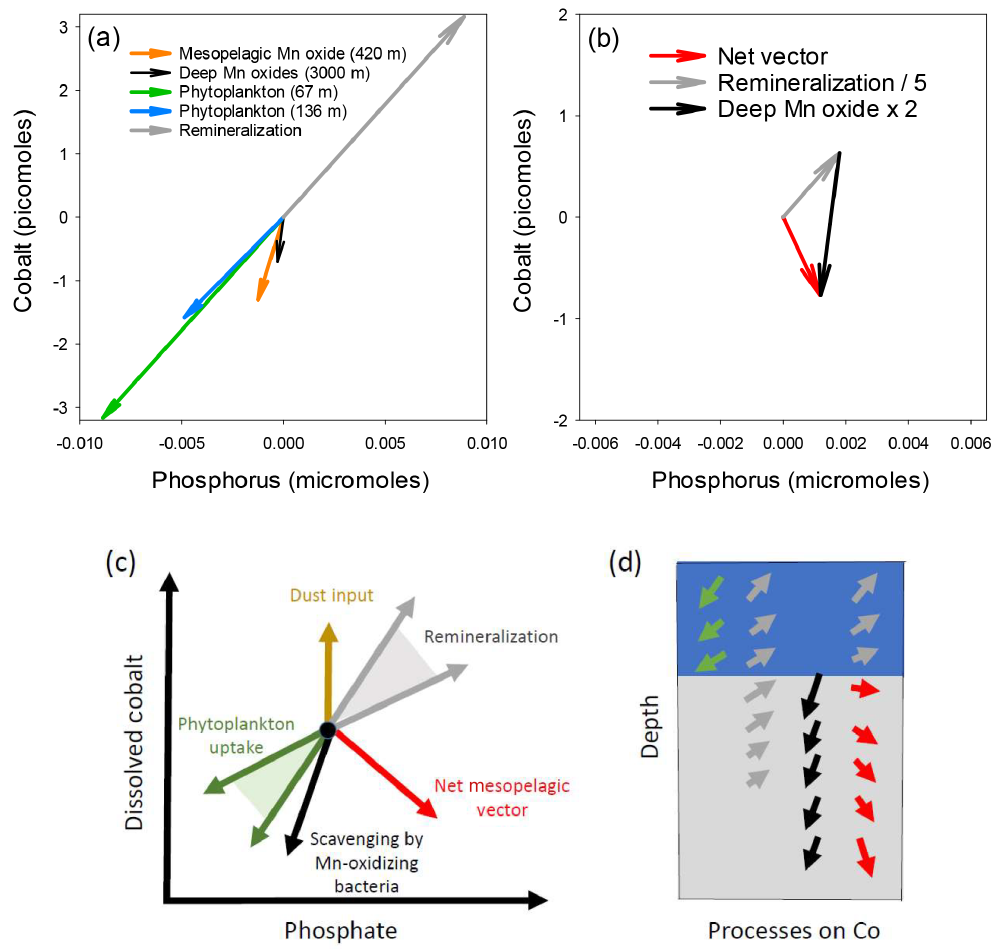
Figure 10. Vector addition demonstrating how negative dCo:P slopes can be generated by addition of scavenging by Mn oxidation and remineralization of phytoplankton material. (a) Vector diagram representing the uptake of dissolved cobalt and phosphorus into particulate Co and P for photosynthetic and manganese co-oxidation processes. These vectors were generated using the measured p Co and p P from Go-Flo bottle samples (67 and 136m) for the upper water column and McLane pump samples for deeper values (420 and 3000m) at Station USGT11- 18. Southwest negative vectors portray the uptake into particles at each depth, while a northeast grey vector portrays remineralization releasing Co and P back to the dissolved phase. (b) Example addition of Mn oxidation vector and phytoplankton remineralization that results in a negative vector as observed throughout the intermediate depths in Figs. 3–6. (c) Idealized version of vector schematic, including the net mesopelagic vector. (d) Idealized relative influence of processes on the dissolved distributions of cobalt and phosphate, using the same color scheme as (b) and (c) and the euphotic zone in blue and mesopelagic in grey. The net vectors summing the influence of all processes are on the far right and are consistent with the shift from positive to negative dCo:P slopes with depth calculated in Fig.